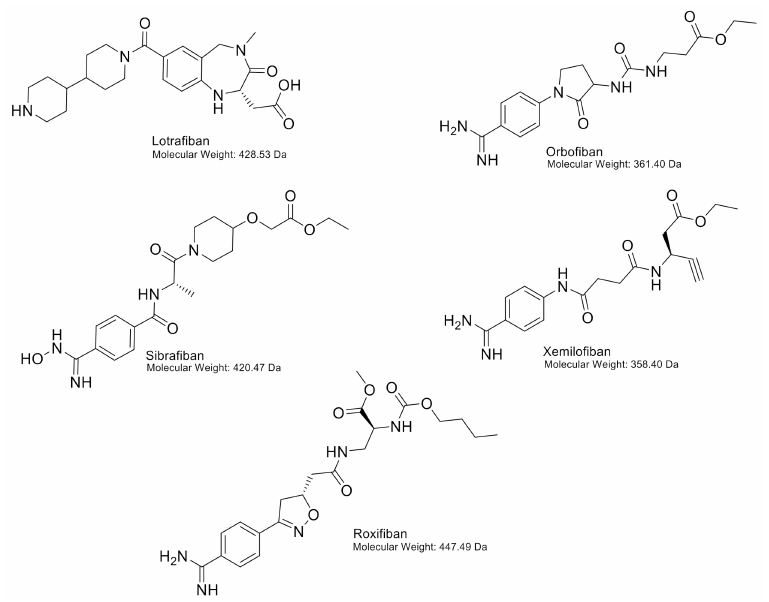
Figure 6. Chemical structures of lotrafiban, orbofiban, sibrafiban, xemilofiban and roxifiban, includ- ing molecular